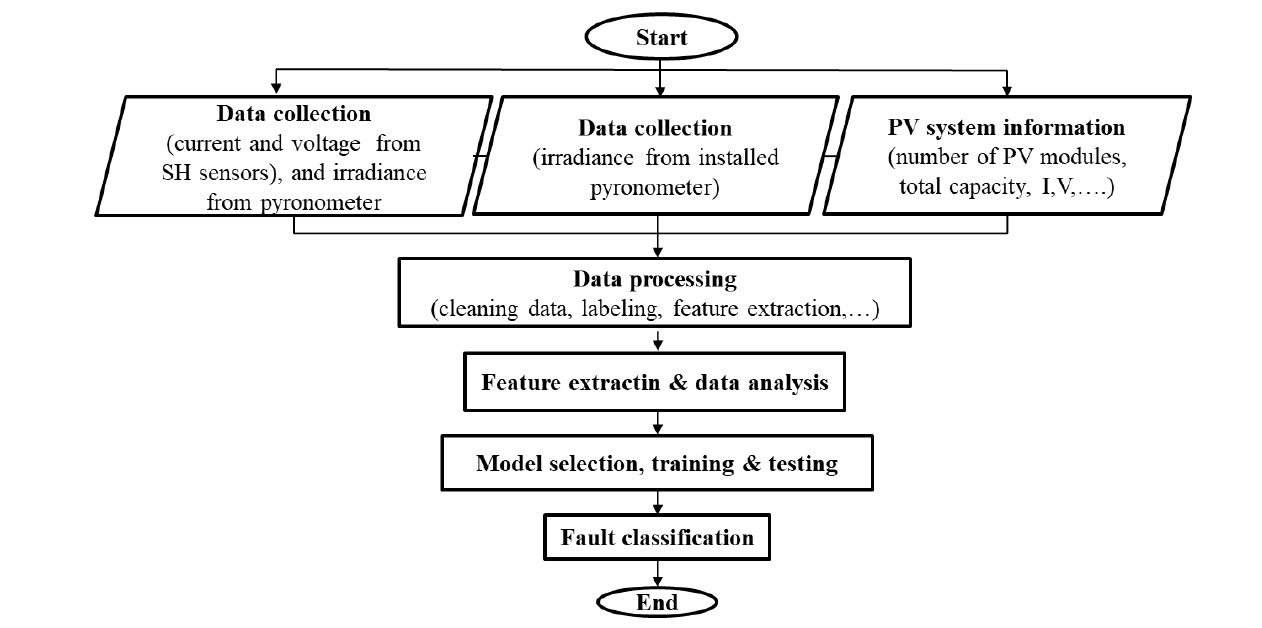
Figure 5. PV fault detection and classification flowchart.